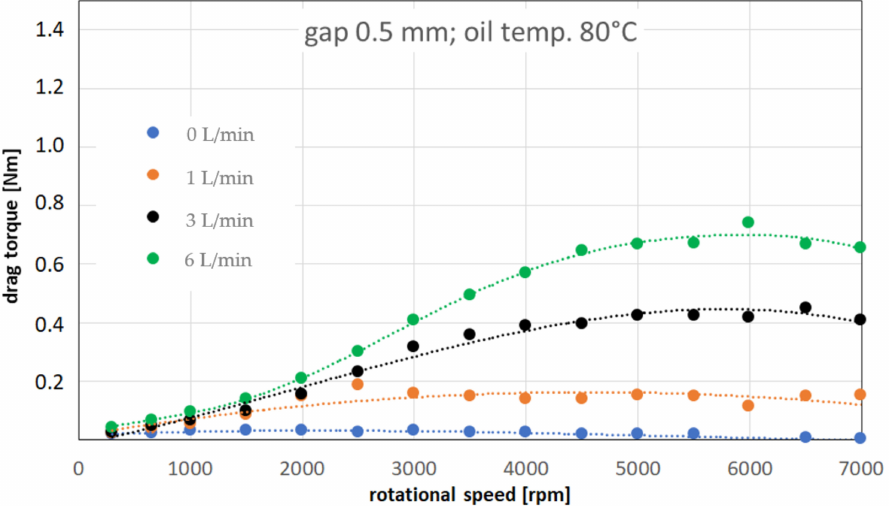
Figure 4. Influence of oil flow rate on drag torque characteristics—gap between plates 0.5 mm, oil temperature 80 ◦ C.